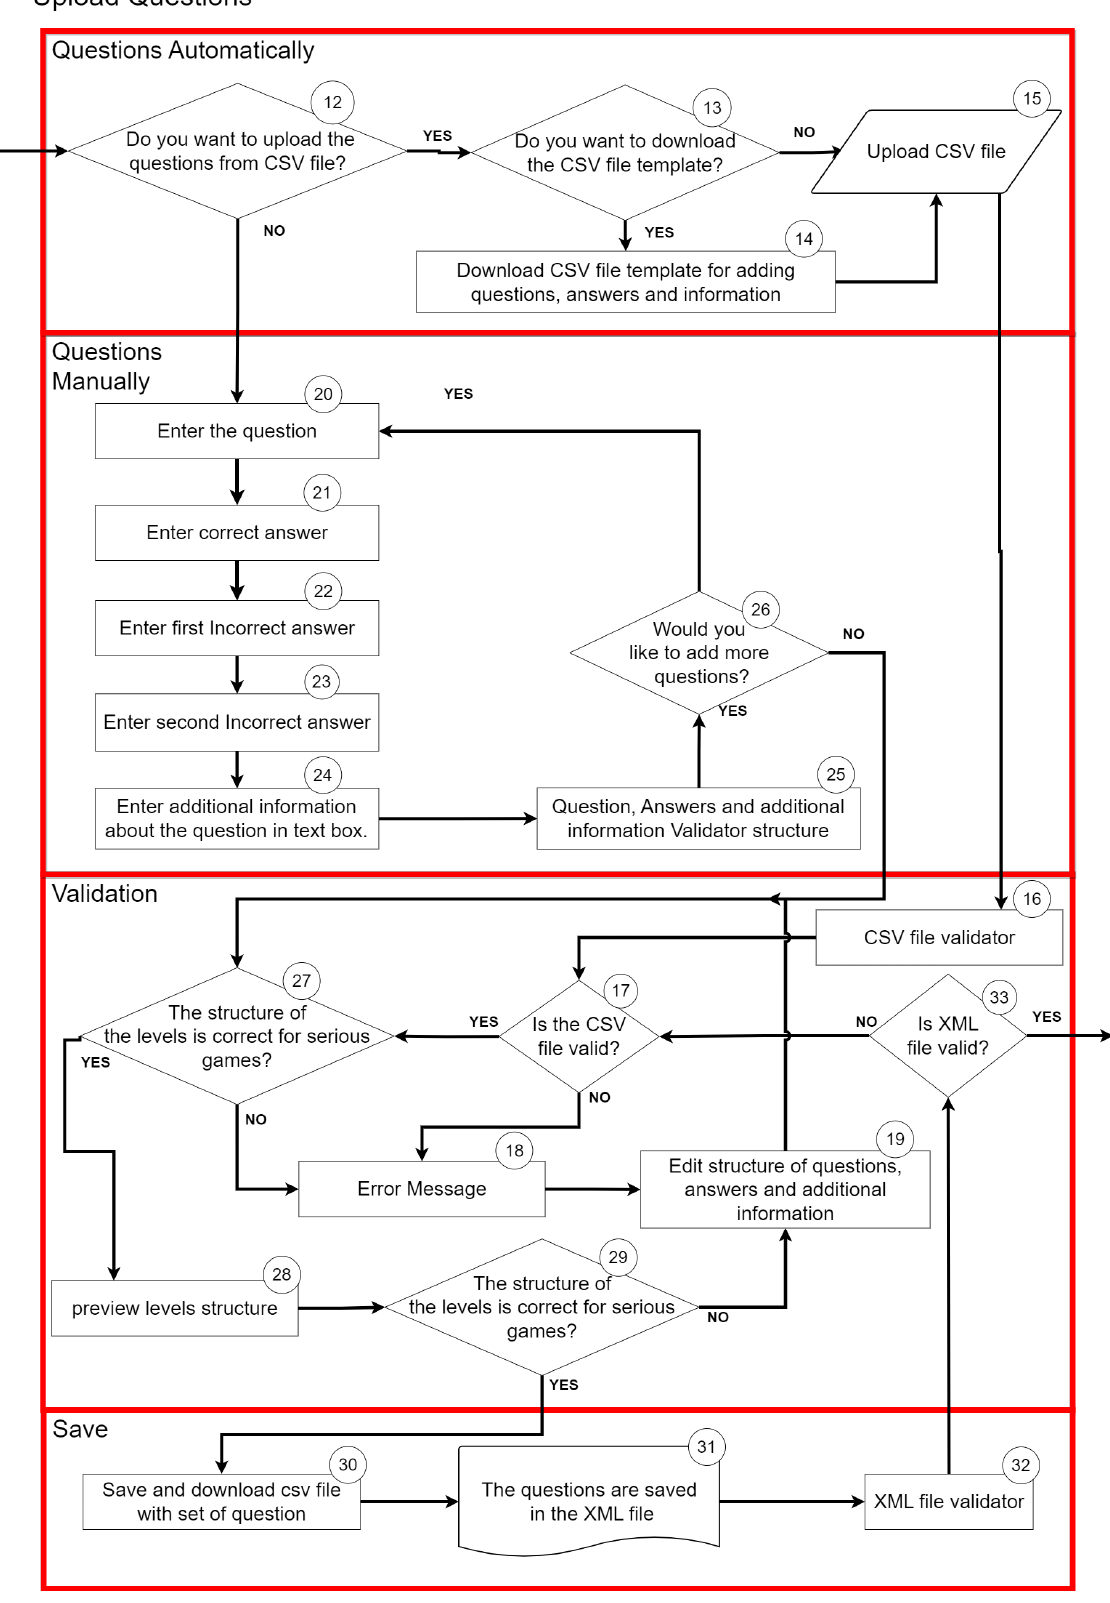
Figure 2. The second part of the flowchart is where you upload questions and